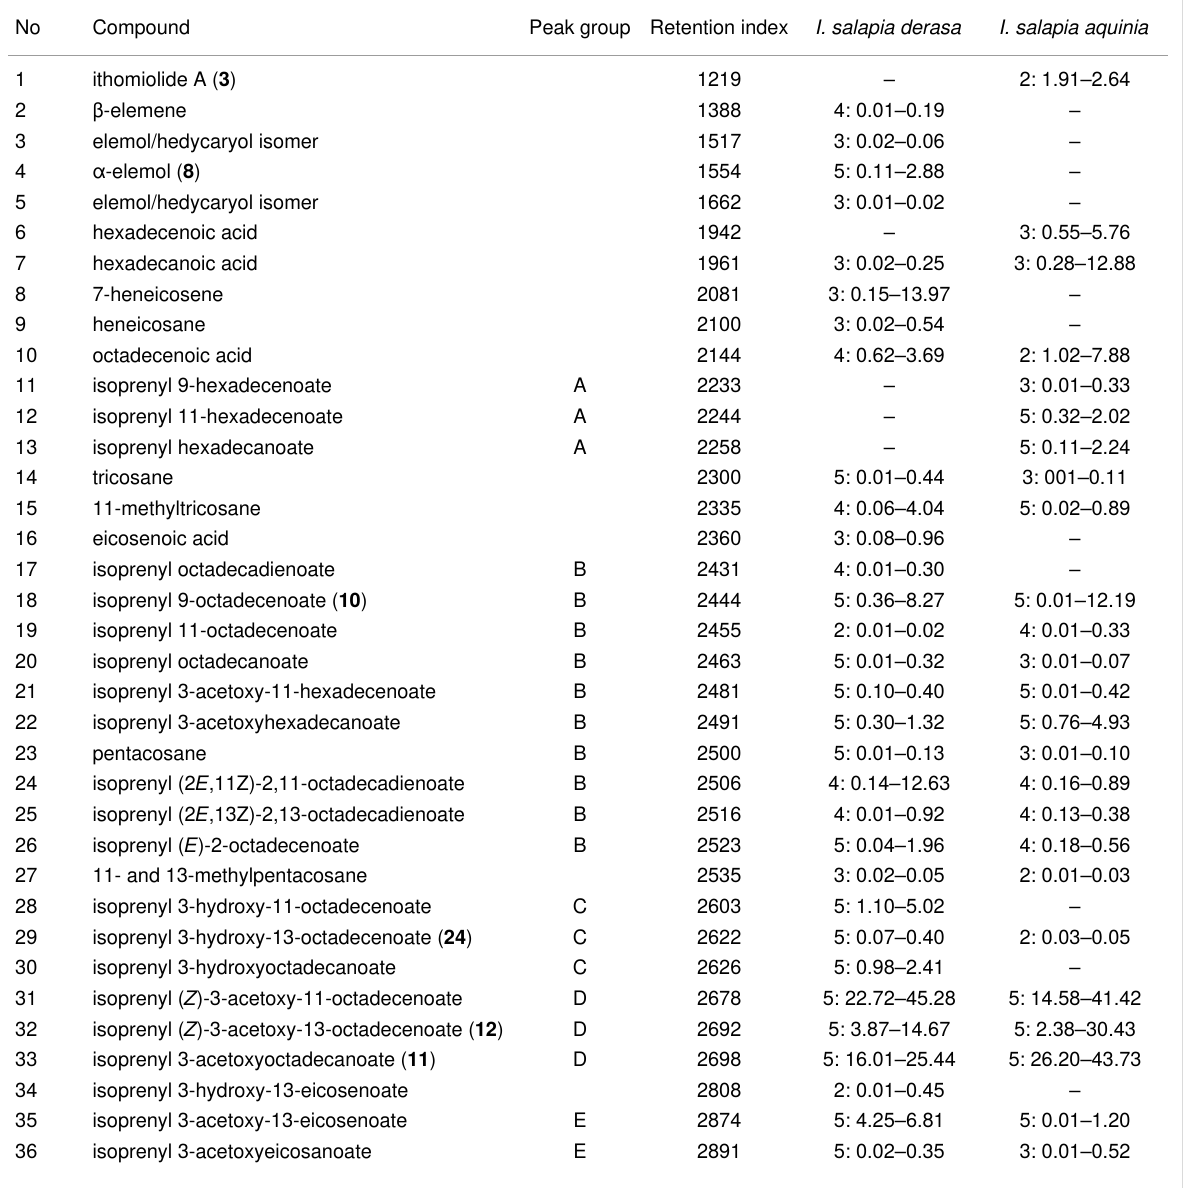
Table 1: Compounds found in extracts of the androconia of Ithomia salapia derasa and I. salapia aquinia. Five individuals of each subspecies were analyzed. Only compounds occurring at least in two individuals of a subspecies are listed. The peak group refers to compounds eluting closely together. The number before the colon indicates the number of individuals carrying this compound, followed by the range of the relative